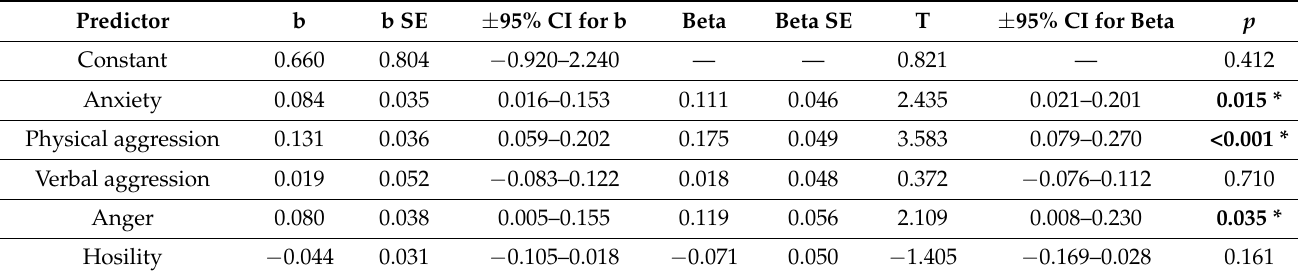
Table 2. Model of regression of the level of alcohol consumption in relation to the intensity of symptoms of anxiety and parts of aggression.